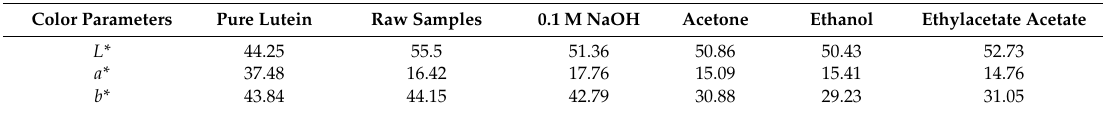
Table 2. Color parameters ofpure lutein, and lutein / LDH samples before and after being immersed into 0.1 M NaOH, acetone, ethanol and ethyl acetate for 24 h, respectively.